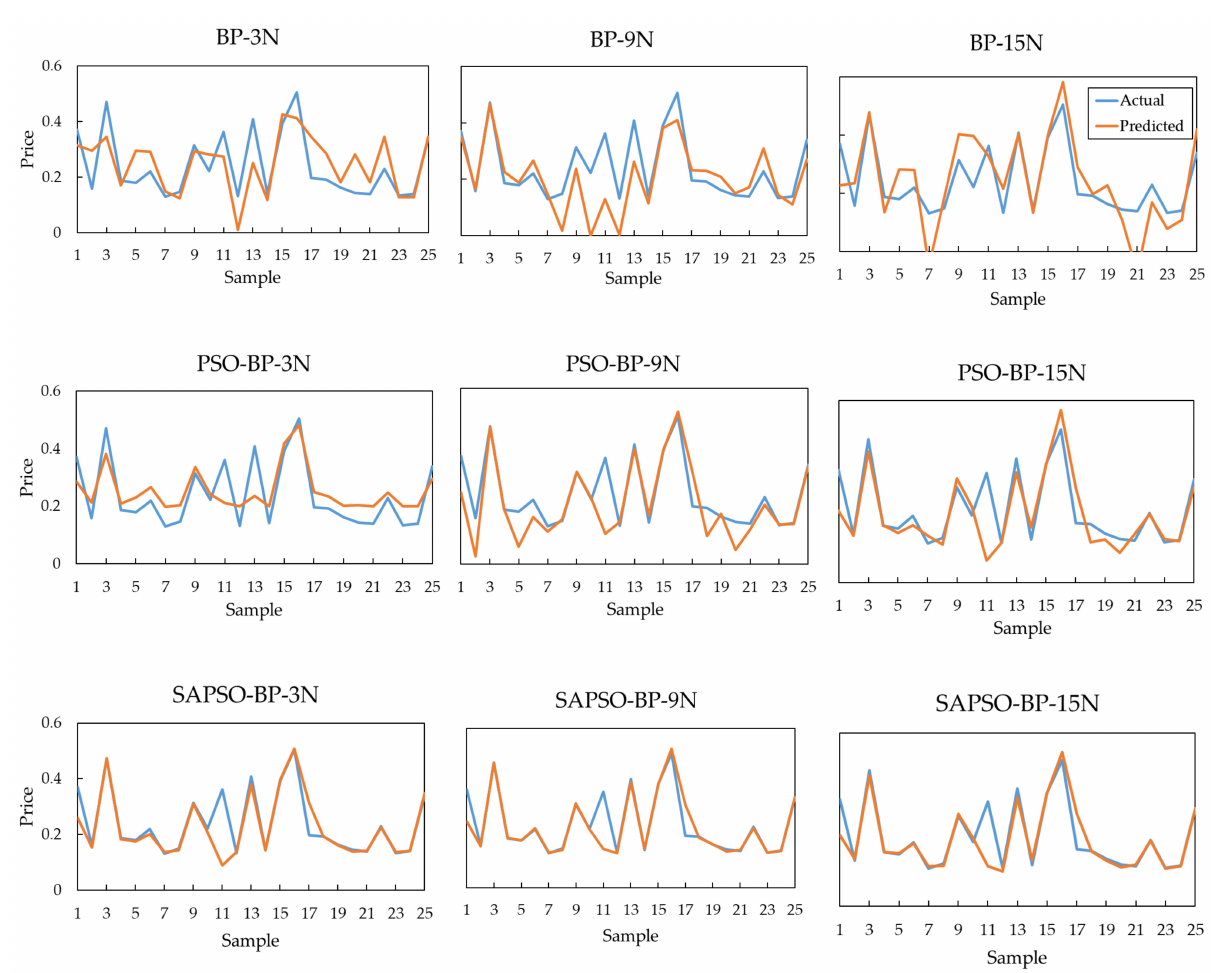
Figure 5. Comparison between predicted electricity price and actual electricity price of 9 models.